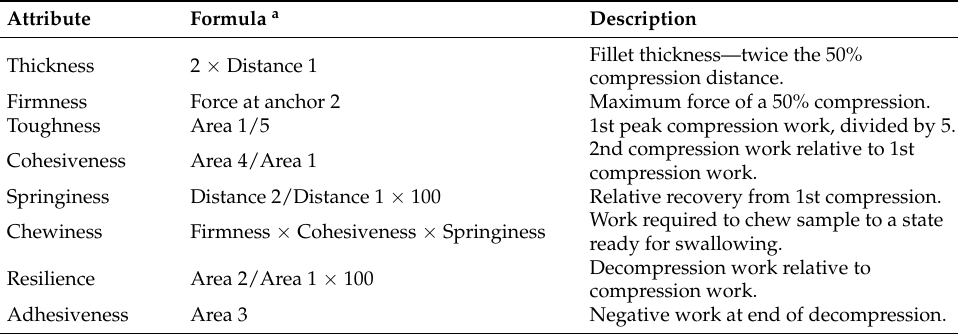
Figure 2. TPA force − time graph showing anchor points used to measure attributes. This was a non-representative sample that showed a separation between anchors 2 and 3. Table 1. Texture profile analysis attributes, with formula and description.